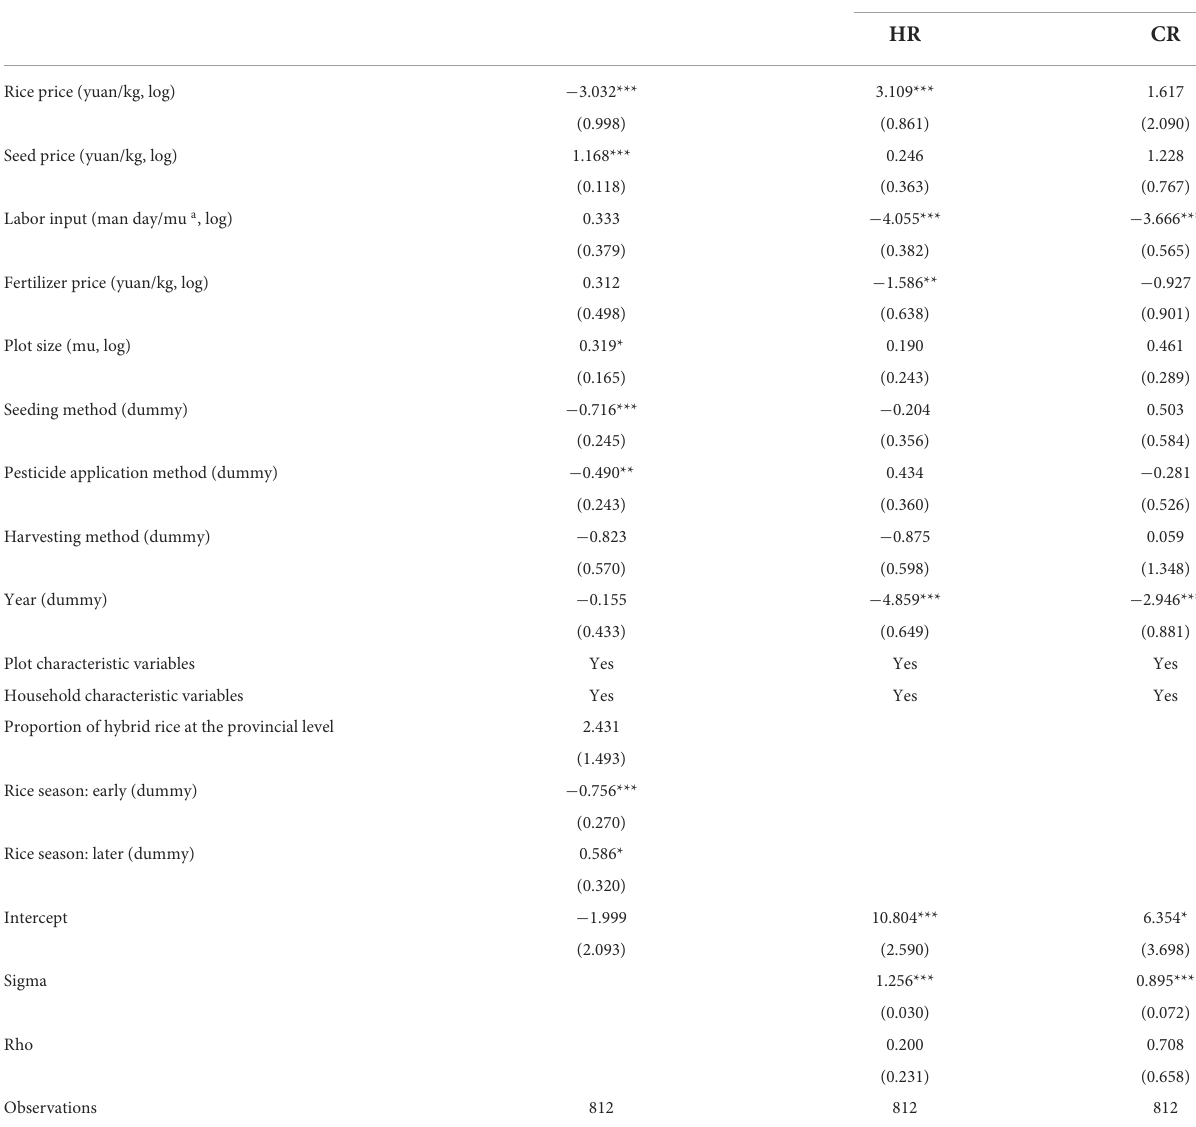
TABLE 4 ESR results for net rice income, China.